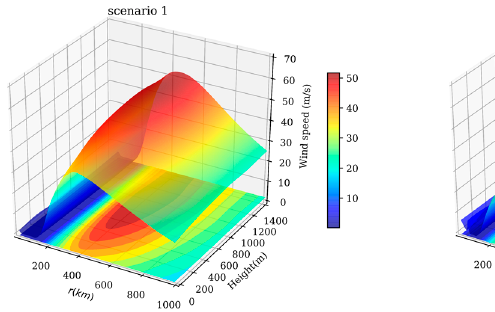
Figure 6. Three-dimensional shaded surfaces of simulated wind speed along with vertical wind profile contours.